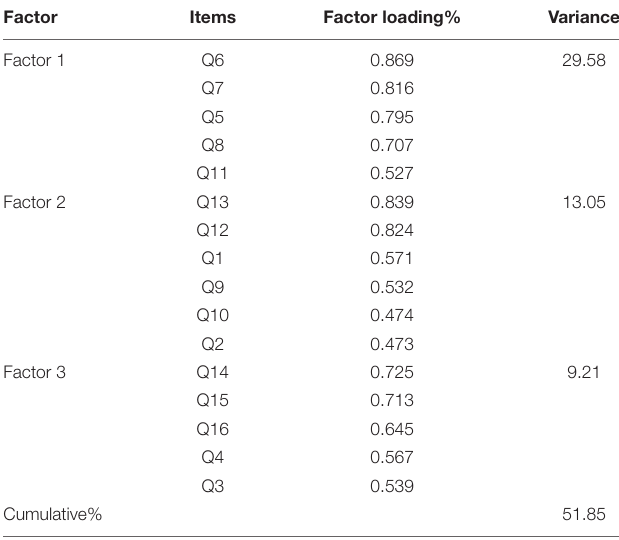
TABLE 2 | Exploratory Factor Analysis of the Persian Version of the QOLLTI – F v3.